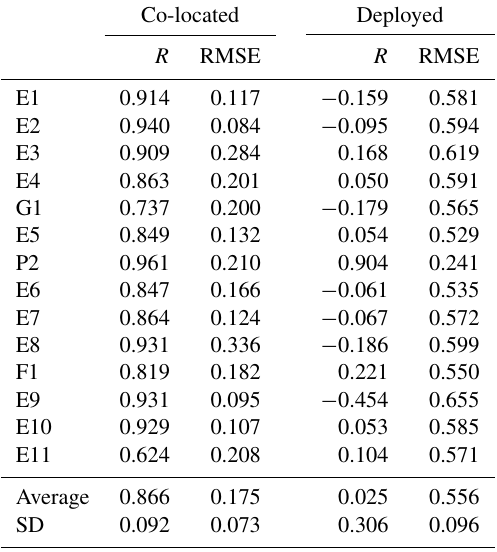
Table A1. Statistics for Colorado data converted using the universal model method, including data for each individual Y-Pod and statis- tics for each Y-Pod versus Y-Pod P1.